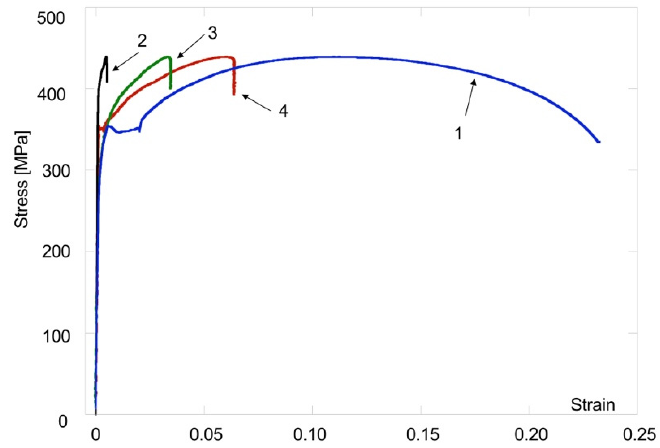
Figure 10. Engineering stress–strain curves of: 1, dissimilar joint (E1 virtual extensometer data); 2, weld zone (E4 virtual extensometer data); 3, HAZ on SS side of the joint (E6 virtual extensometer data); 4, HAZ on CS side of the joint (E5 virtual extensometer data).